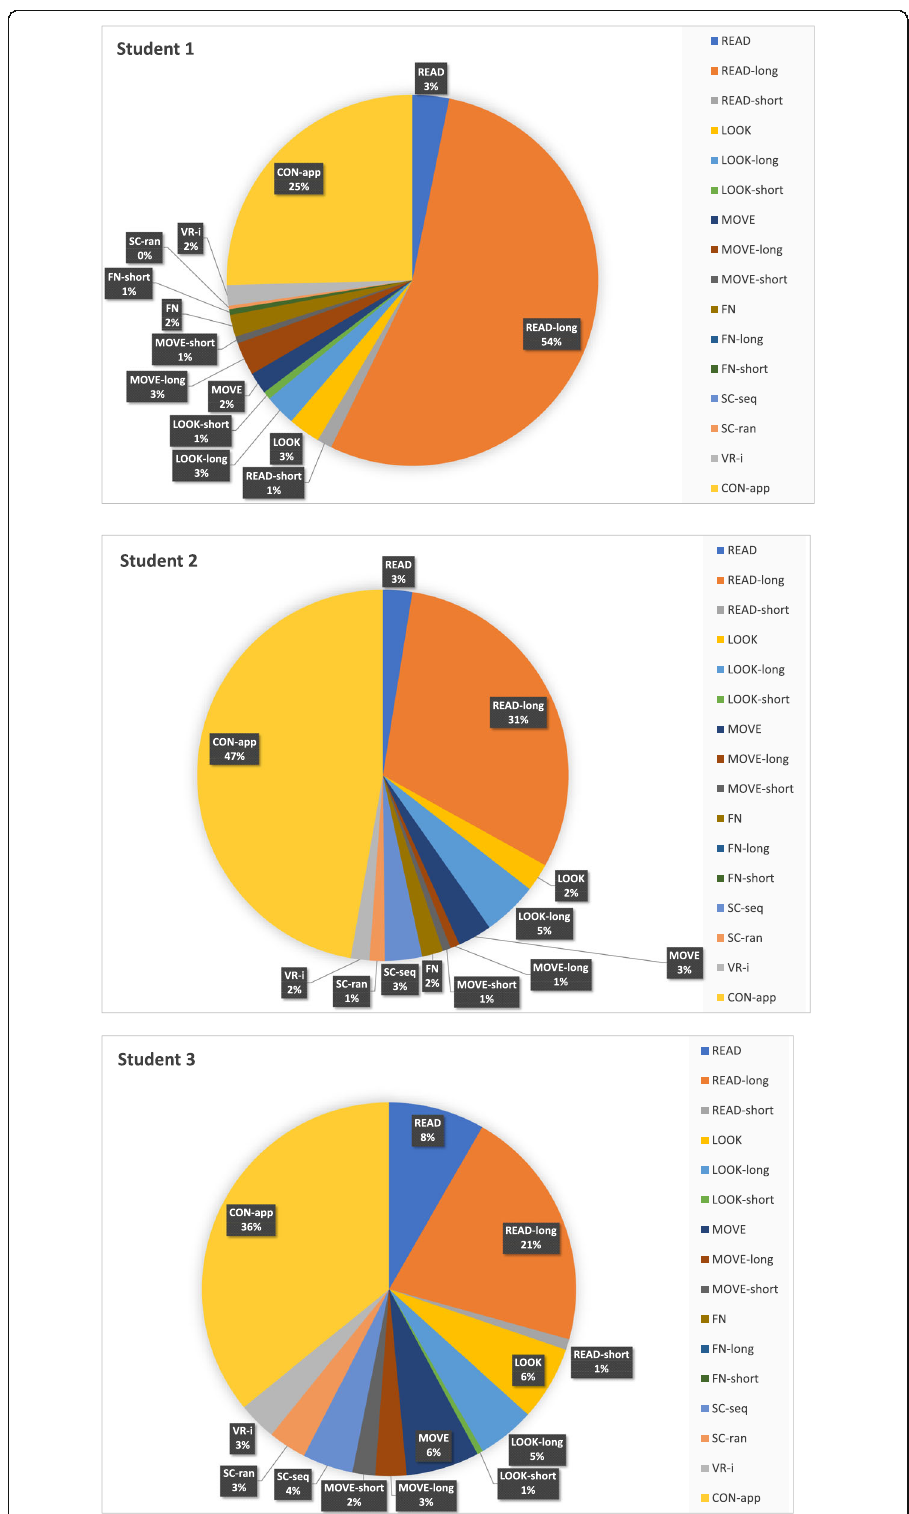
Fig. 3 a Time spent in various actions by learner 1 in VR. b Time spent in various actions by learner 2 in VR. c Time spent in various actions by learner 3 in